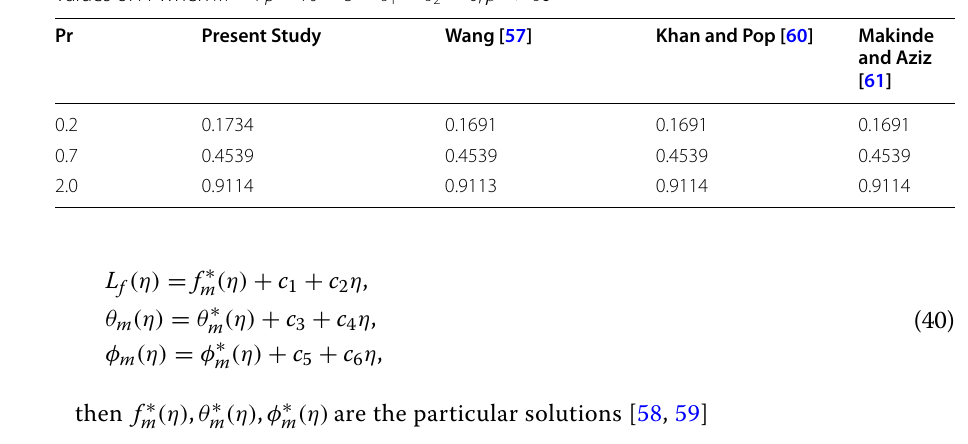
Table 4 Comparison of wall heat transfer rate values of Pr when M